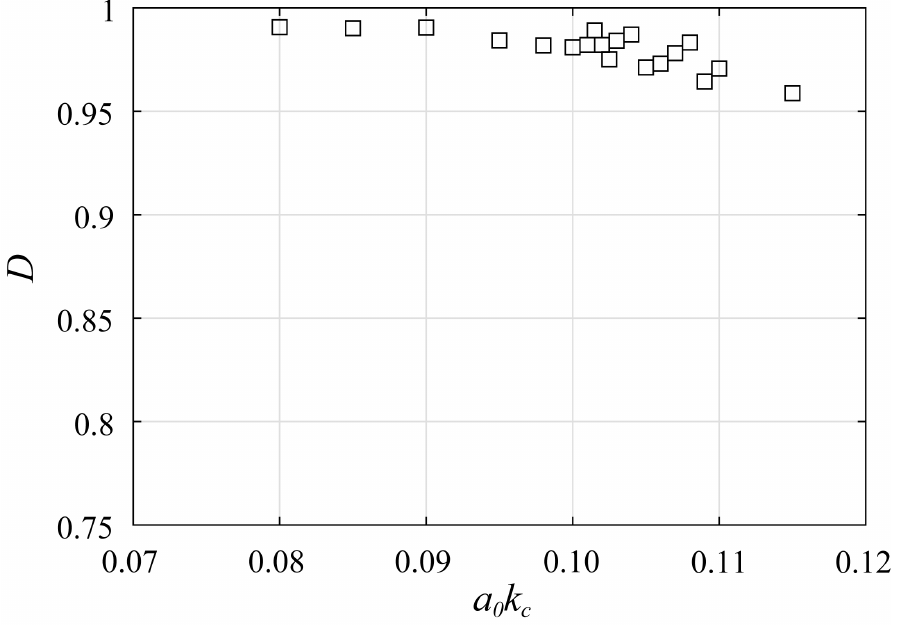
Figure 14. Relation between the initial wave steepness and degree of phase convergence at the time of the maximum crest height, obtained from the HOSM